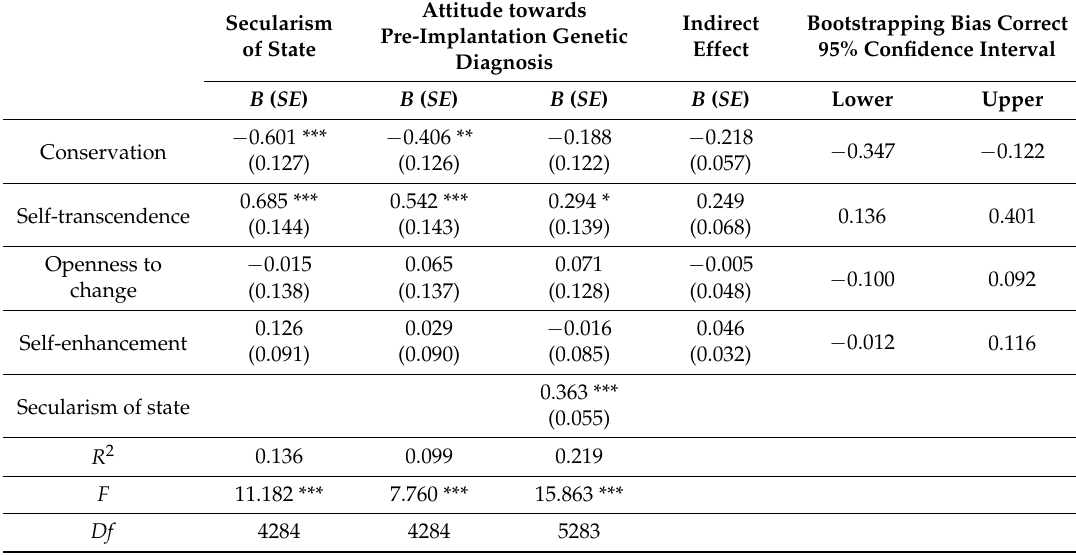
Table 2. Mediating effects of secularism of state. Dependent variable: attitude towards pre-implantation genetic diagnosis